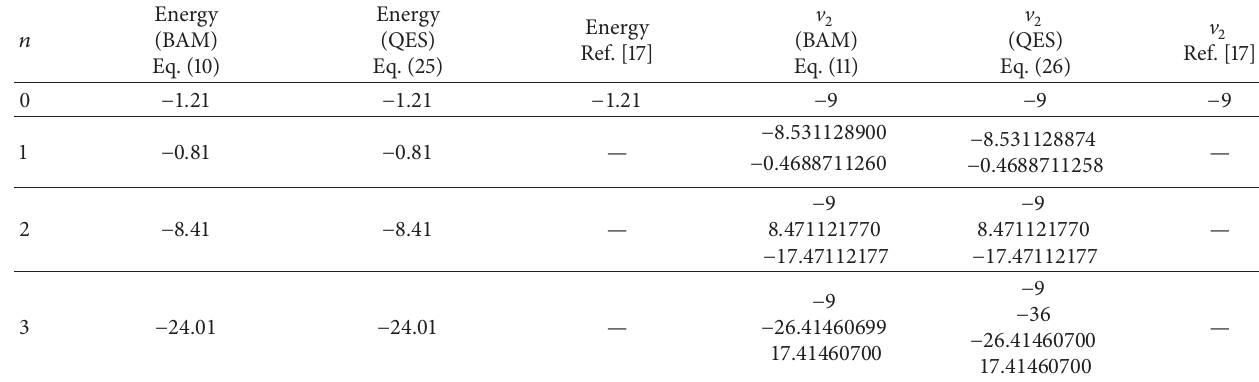
Table 1: Solutions of the first four states for the QES DWP with V 1 = 0.09 , V 3 = 10 , and 𝑔 = 1/4